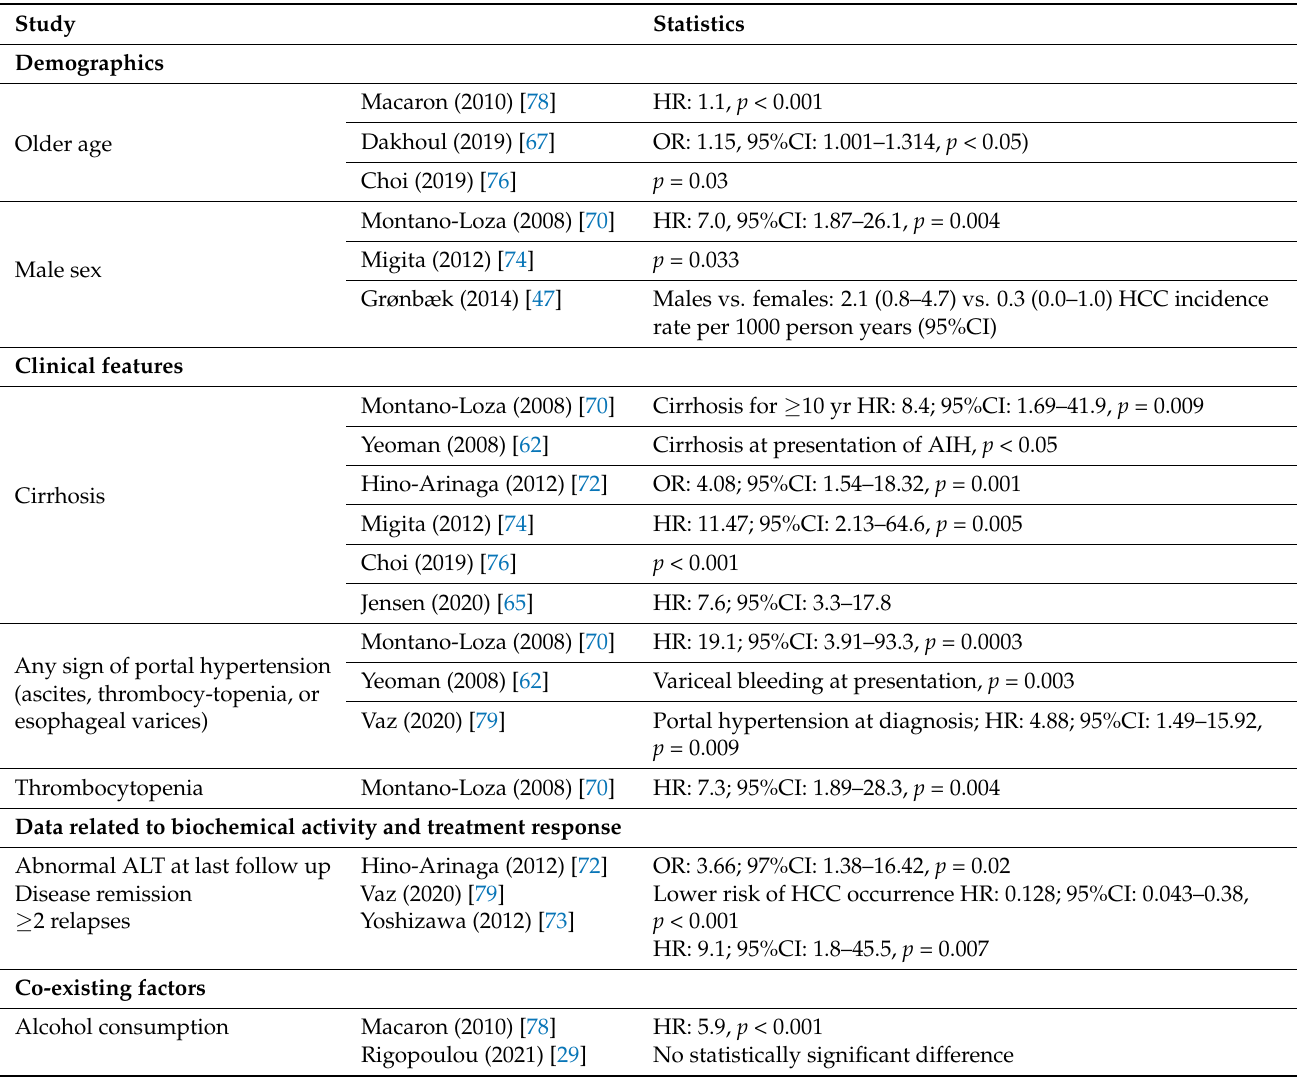
Table 2. Risk factors for hepatocellular carcinoma in patients with autoimmune